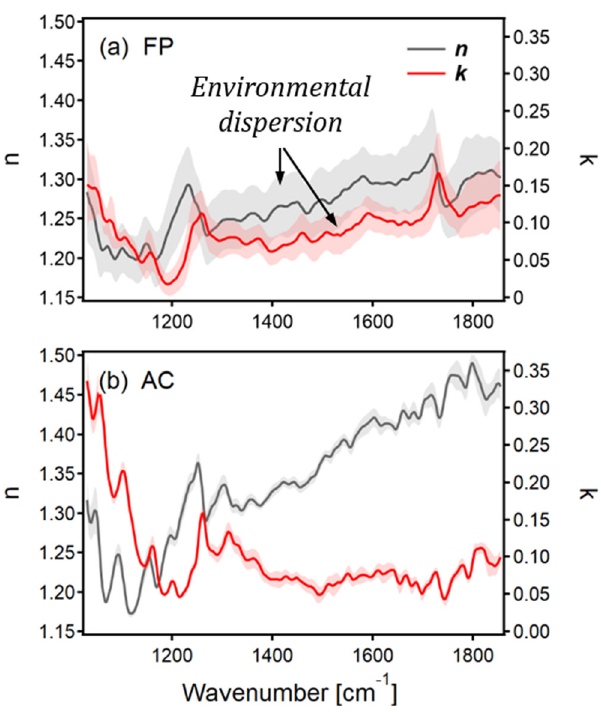
Fig. 6 Environmental chemical variability evidenced through the optical dispersion. Determination of the average optical properties of plant material via measurement of the complex index of refraction n + ik . The average refractive index n and extinction coef fi cients k for a untreated FP and b holopulped AC samples were determined from the amplitude and phase of the scattering near fi eld recorded along a line. The corresponding shaded areas are the standard deviations which re fl ect the environmental dispersions of n and k